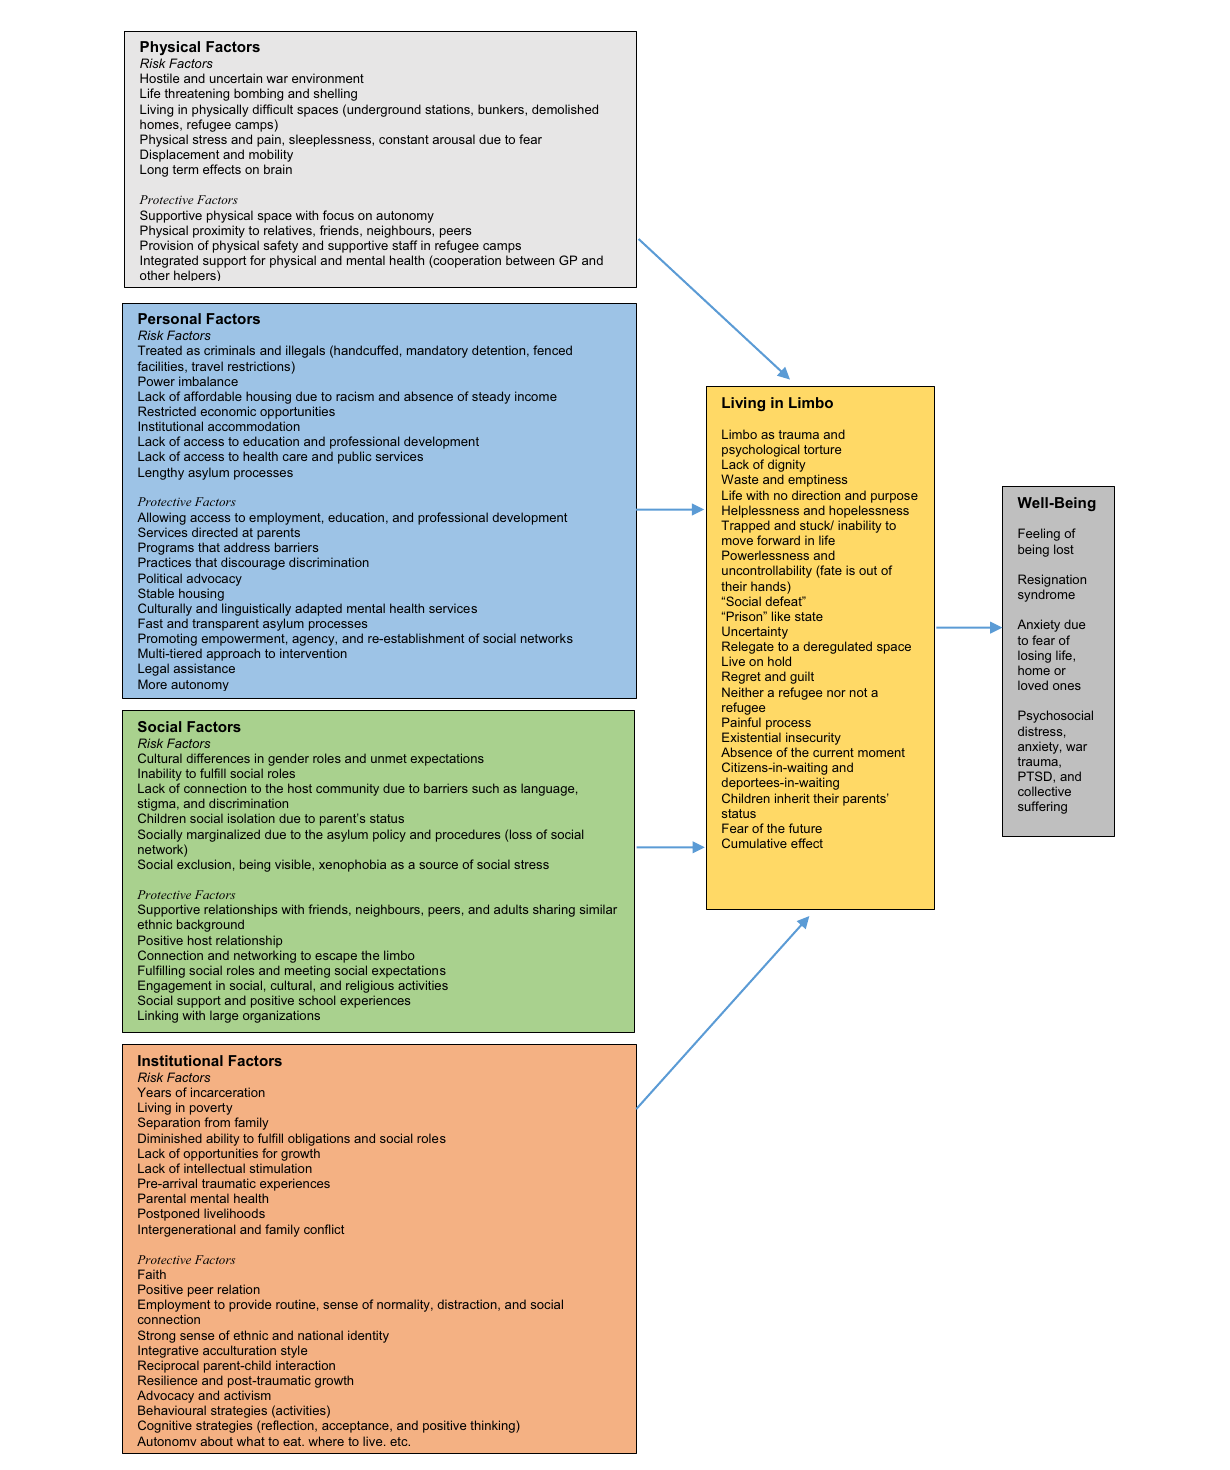
FIGURE 1 Multilevel factor affecting life and wellbeing of war civilians, asylum seekers, and